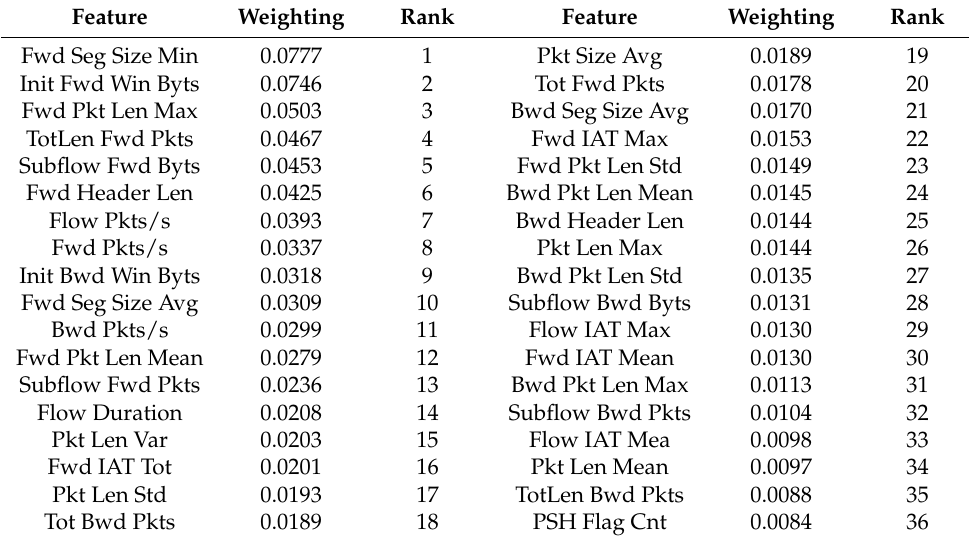
Table 11. Top 36 features by weight. (CSE-CIC-IDS